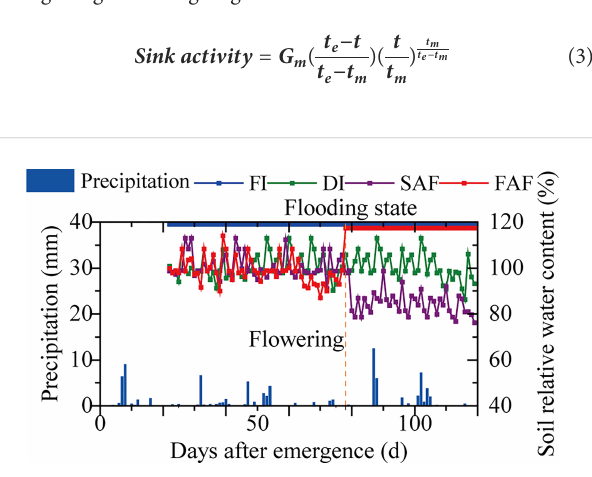
FIGURE 1 Dynamics of precipitation and soil relative water content in four water strategies during rice growing season (Xinjiang Tianye Agricultural Research Institute, Northwest China, 2021). FI, the whole growing season fl ooding; DI, the whole growing season normal drip irrigation (soil relative moisture (RSM) was maintained in a range